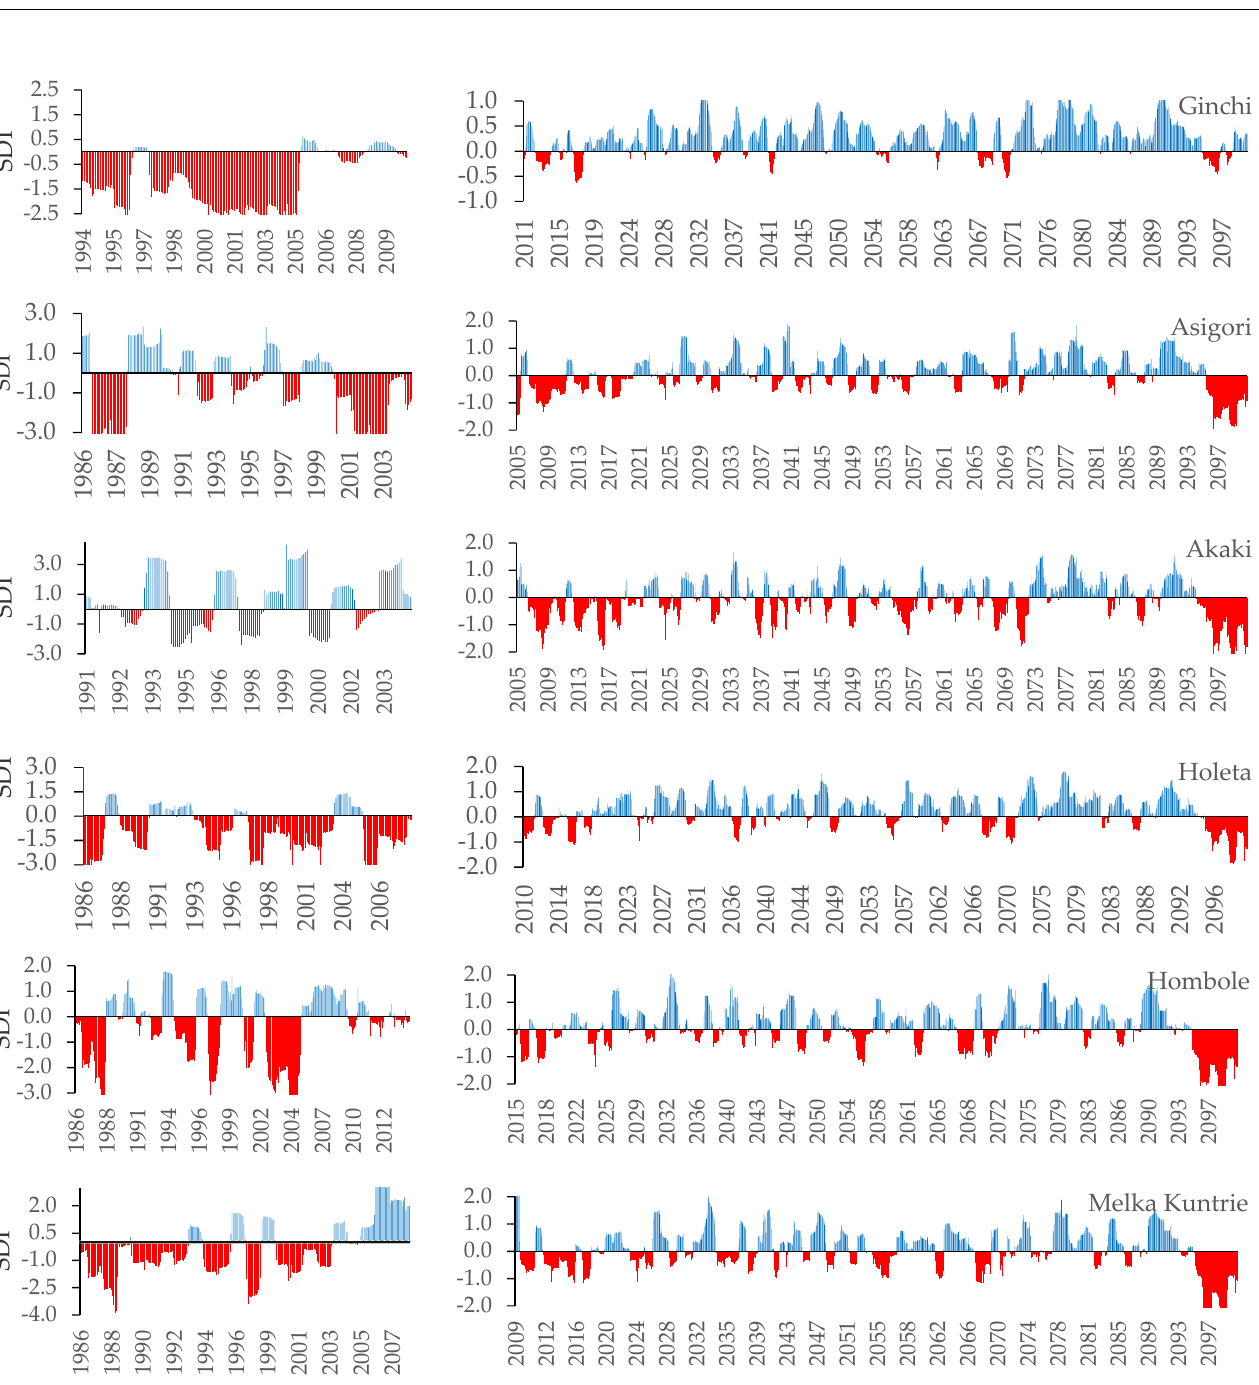
Figure 8. Hydrological drought index for the baseline and ensemble mean based on the five GCMs’ ensemble mean (blue indicates wet years and red dry years).